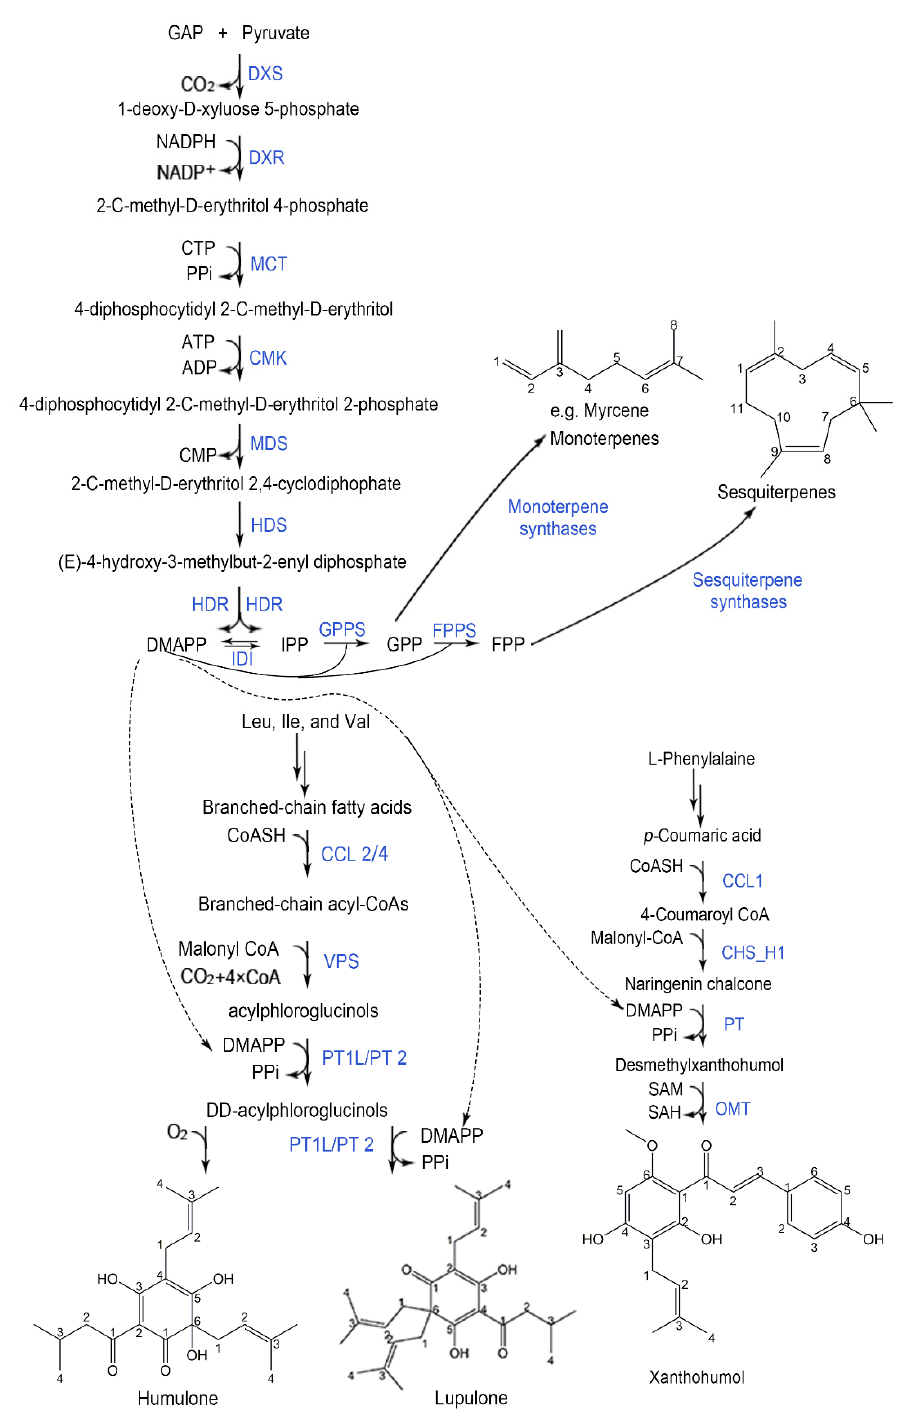
Figure 1. Biosynthesis pathways of several hop secondary metabolites. DXS: 1-deoxyxylulose-5- phosphate synthase; DXR: 1-deoxy-d-xylulose-5-phosphate reductoisomerase; MCT: 2-C-methyl- D -erythritol 4-phosphate cytidylyltransferase; CMK: 4-diphosphocytidyl-2-C-methyl- D -erythritol kinase; MDS: 2- C -methyl- D -erythritol 2,4-cyclodiphosphate synthase; HDS: 4-hydroxy-3-methylbut- 2-enyl diphosphate synthase; HDR: 4-hydroxy-3-methylbut-2-enyl diphosphate reductase; IDI: I IPP isomerase isoenzymes; GPPS: geranylpyrophosphate synthase; FPPS: farnesyl-pyrophosphate synthase; CCL: Carboxyl CoA ligase; VPS: valerophenone synthase; PT: prenyltransferase; CHS_H1: chalcone synthase; OMT:O-methyltransferase.